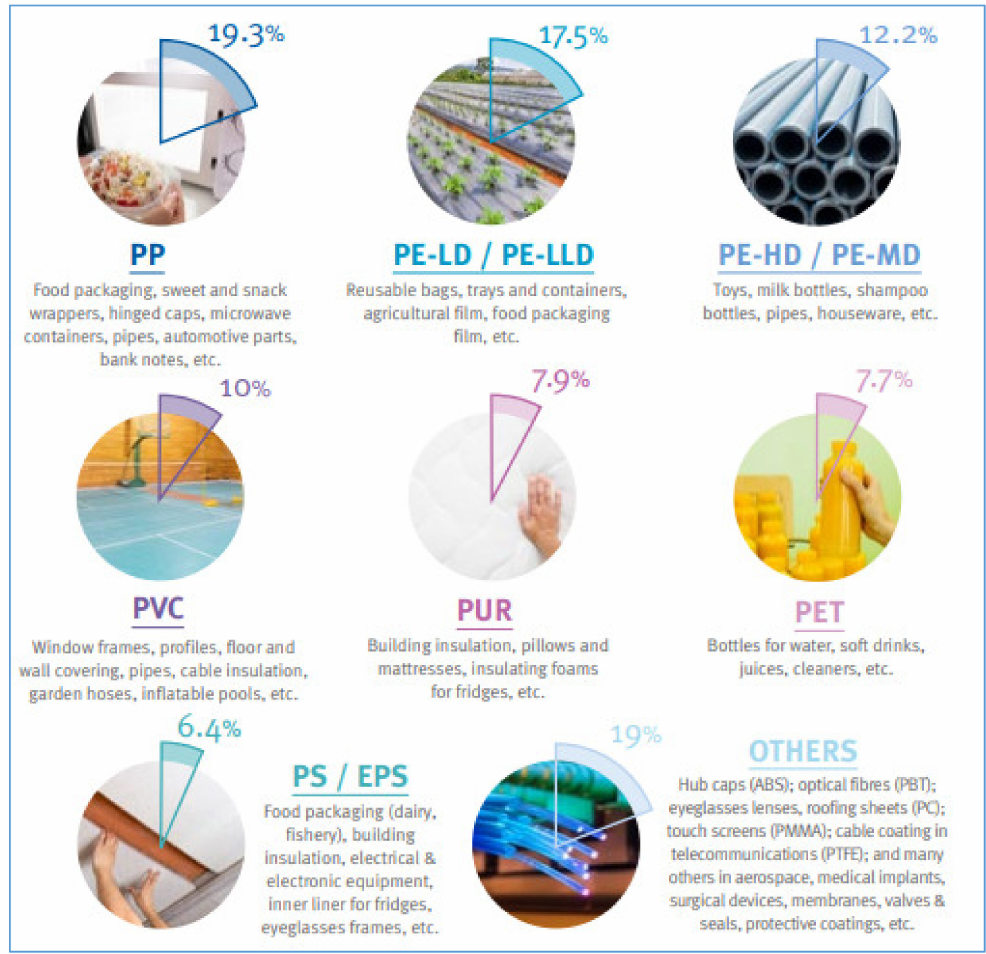
Figure 1. Distribution of plastics demand by resin types in the year 2018. Reprinted from [4], © 2020 with permission from